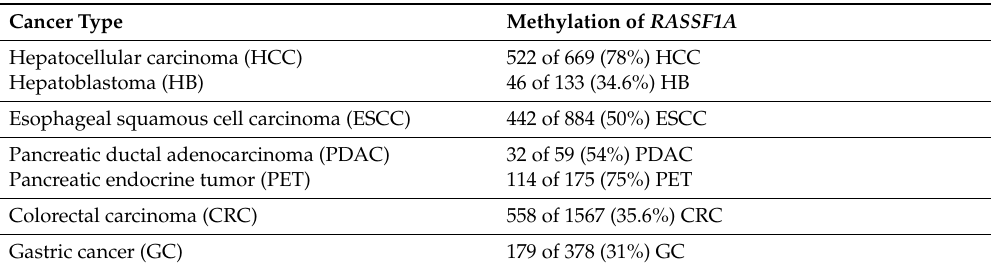
Table 1. Frequency of RASSF1A methylation in gastrointestinal cancers